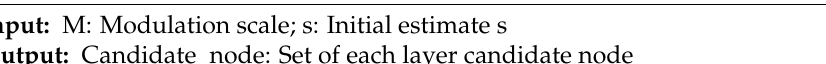
Figure 8. Flowchart of candidate node selection (taking layer 4 as an example). Algorithm 1 Sample